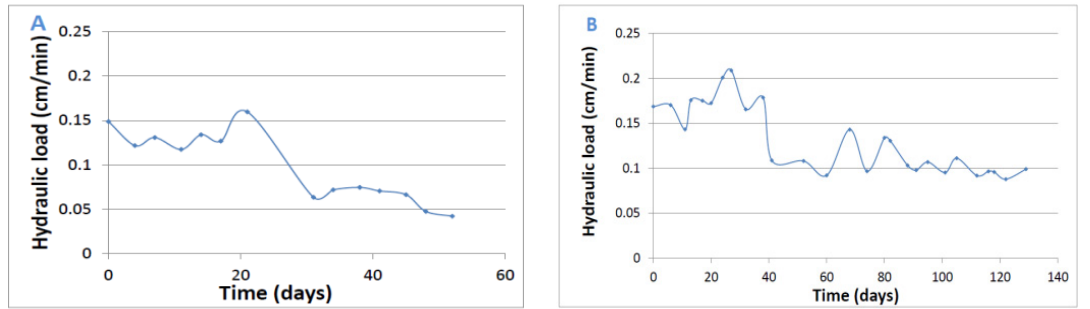
Figure 2. Hydraulic load as a function of time in ( A ) Phase I and ( B ) Phase II.